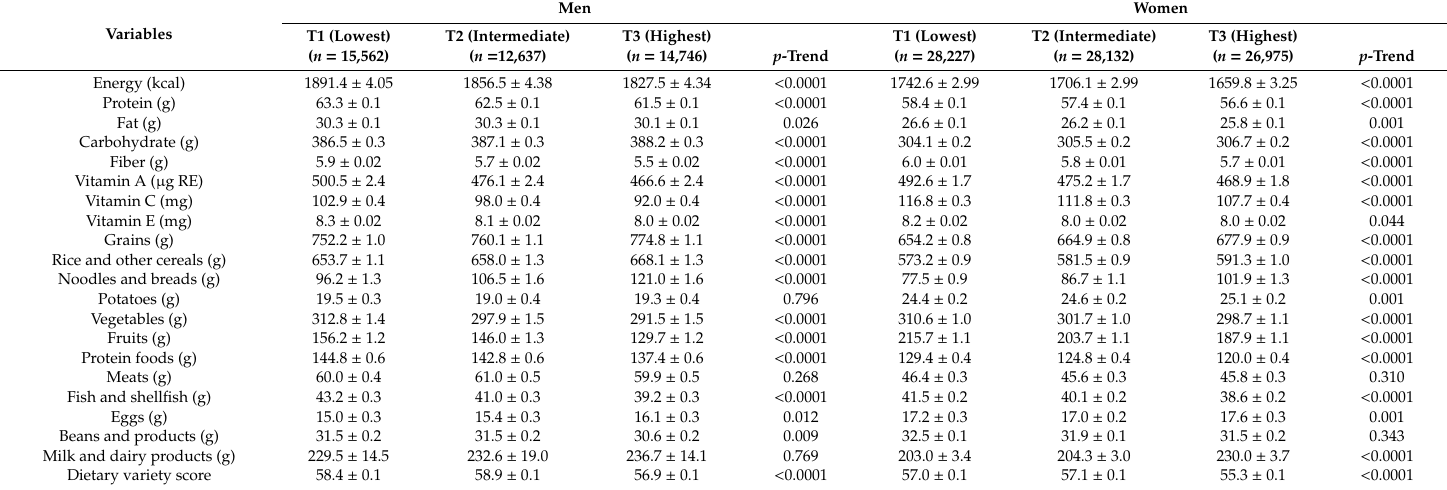
Table 3. Dietary intakes of the subjects by tertiles of stress levels.